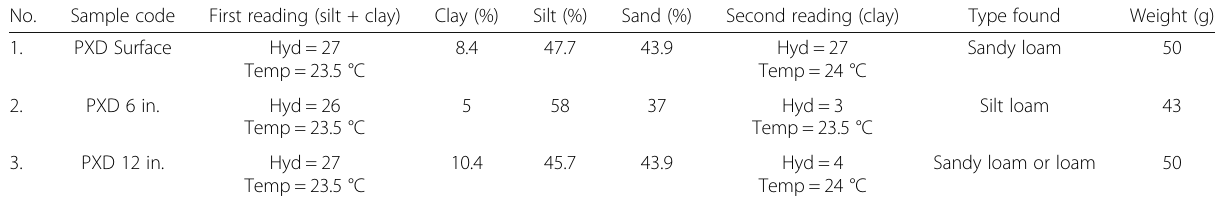
Table 3 Texture analysis of soil samples